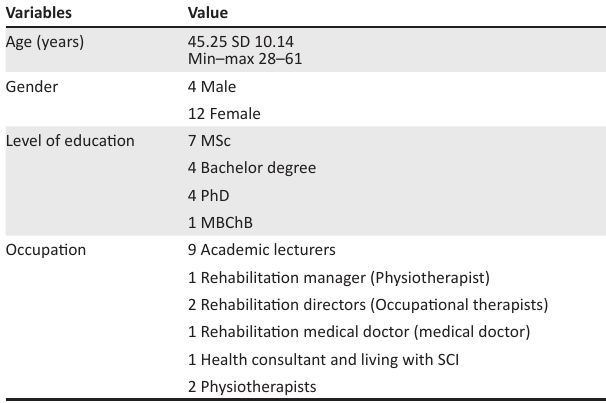
TABLE 1: Demographic profile ( n =